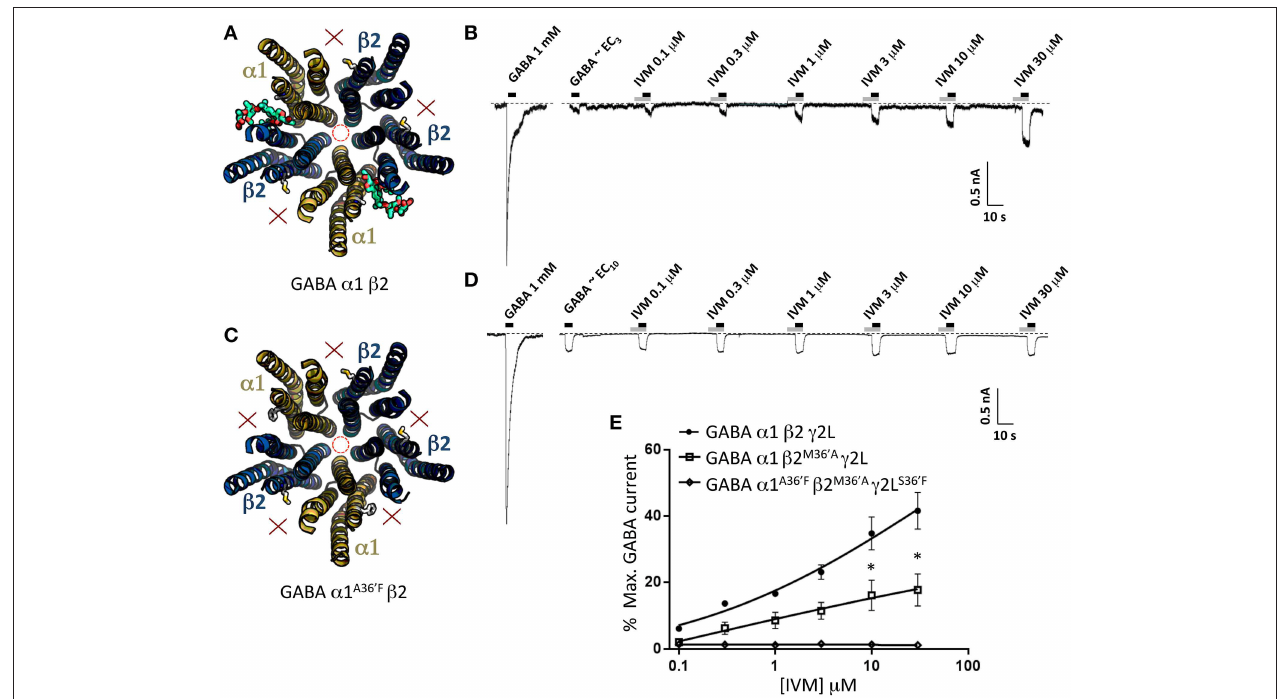
FIGURE 7 | Effects of ivermectin on α 1 β 2 and α 1 A36 β 2 GABA A Rs. (A) Structural model of α 1 β 2 showing the location of the ivermectin binding sites. (B) Sample recording showing the effect of increasing ivermectin concentrations on EC 10 GABA-gated currents in α 1 β 2 GABA A Rs. (C) Structural model of α 1 A36 showing the lack of ivermectin binding sites. (D) Sample recording showing the effect of increasing ivermectin concentrations on EC 10 GABA-gated currents ′ F α 1 A36 β 2 GABA A Rs. (E) Mean concentration-response data for the experiments as shown in (B,D) . * Represents significance of t -test P <